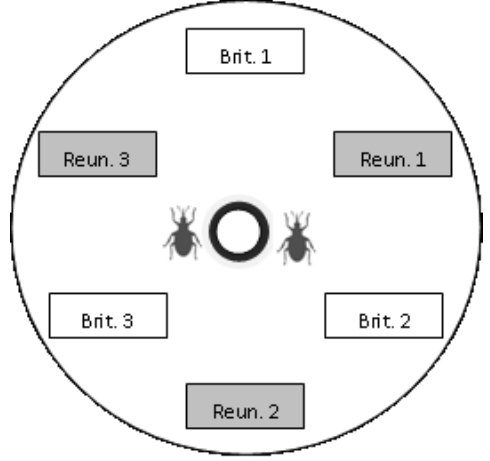
Figure. 1. Scheme of the choice device. Pods of each region and population were placed alternately, at an equal distance from the centre of the dish. In this example, the ―Brit. 1‖ box represents a pod from population 1 of Brittany. At the beginning of an experiment, weevils were placed at the centre of the dish, near the water supply (bold black